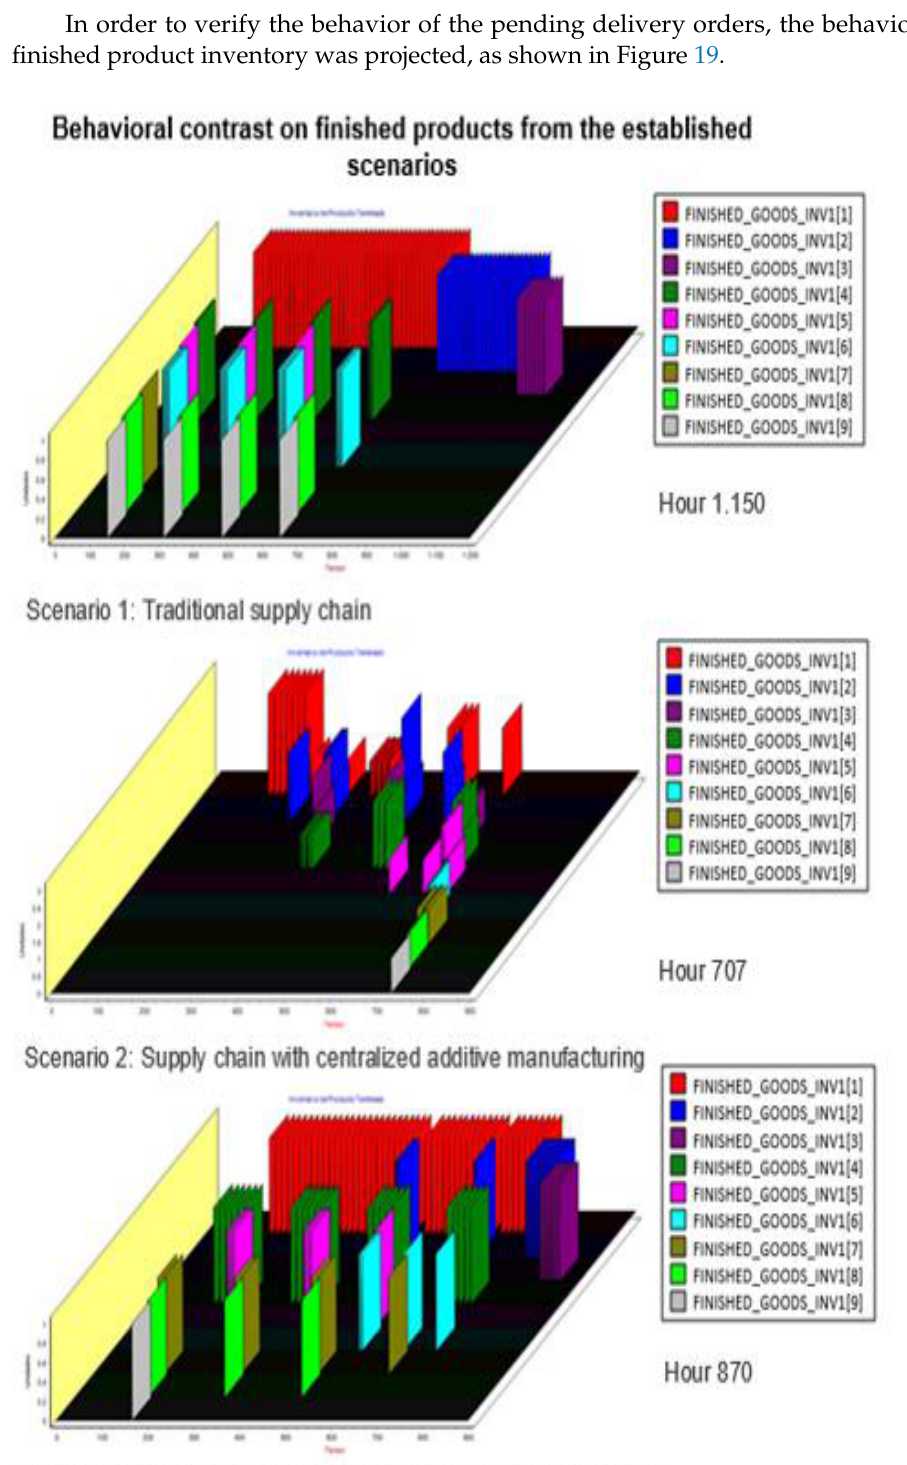
Figure 19. Behavioral contrast on finished product inventory from the established scenarios. Source: own elaboration. Simulation results obtained from Evolution software.